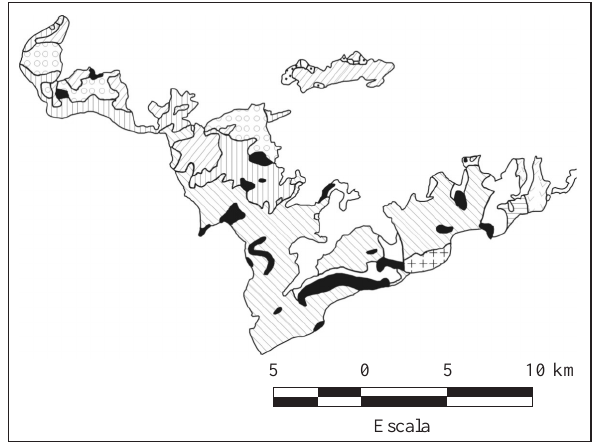
Figura 2. Classes de aptidão para reflorestamento das terras da vertente norte do maciço da Tijuca, sub-bacias dos canais do Mangue e do Cunha, Rio de Janeiro (RJ) (como definidas no Quadro